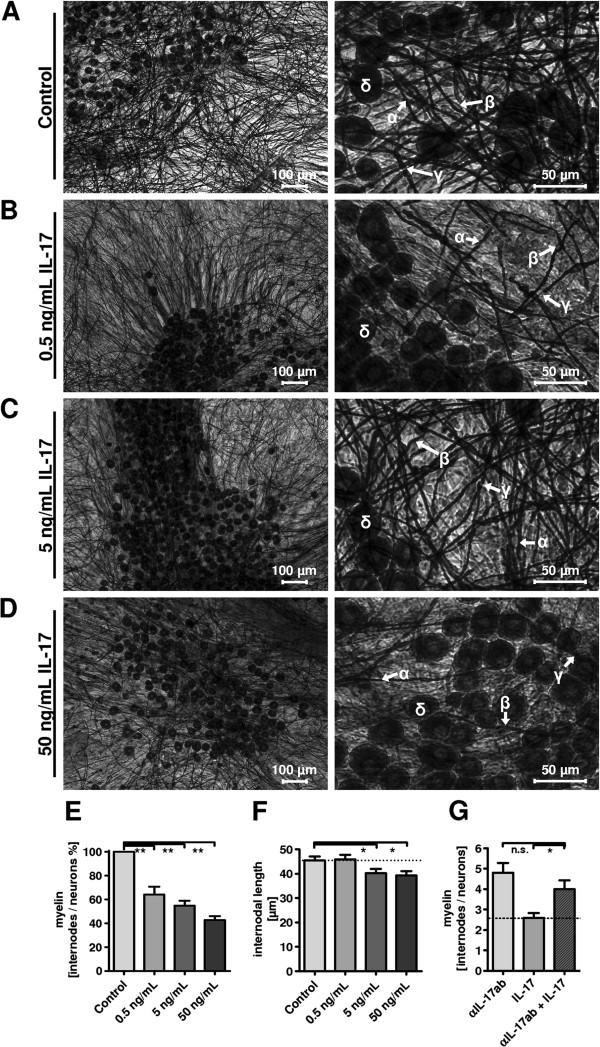
Myelin morphology and quantification after interleukin 17 (IL-17) treatment. (A-E) For myelin quantification, mouse dorsal root ganglia (DRG) co-cultures were exposed to IL-17 for 21 days at the indicated concentrations and subsequently stained, using Sudan black dye. Images show myelin layer (α) and Schwann cell body (β) are separated from the next internode by Ranvier’s node (γ) and neuronal cell bodies (δ). In analysis of three independent experiments, quantification revealed a myelin ratio (internodes to neurons) reduction to 66% for 0.5 ng/mL IL-17 (**P = <0.01), to 55% for 5 ng/mL IL-17 (**P = <0.01), and to 42% for 50 ng/mL IL-17 (**P = <0.01), each compared with control stimulations. (F) Internodal distances after exposure to IL-17 revealed a significant decrease with 5 ng/mL IL-17 (*P = <0.05) and 50 ng/mL IL-17 (*P = <0.05). Analysis of variances between the independent experiments revealed no significant difference. (G) Myelin quantification of Sudan-stained DRG co-cultures after treatment with IL-17, an IL-17-neutralizing antibody (αIL-17ab), and co-stimulation of three independent experiments, respectively. The myelin-inhibitory effect of IL-17 was reduced by 81% after supplementation with αIL-17ab. Myelination was restored to the base level, similar to treatment with the antibody alone.